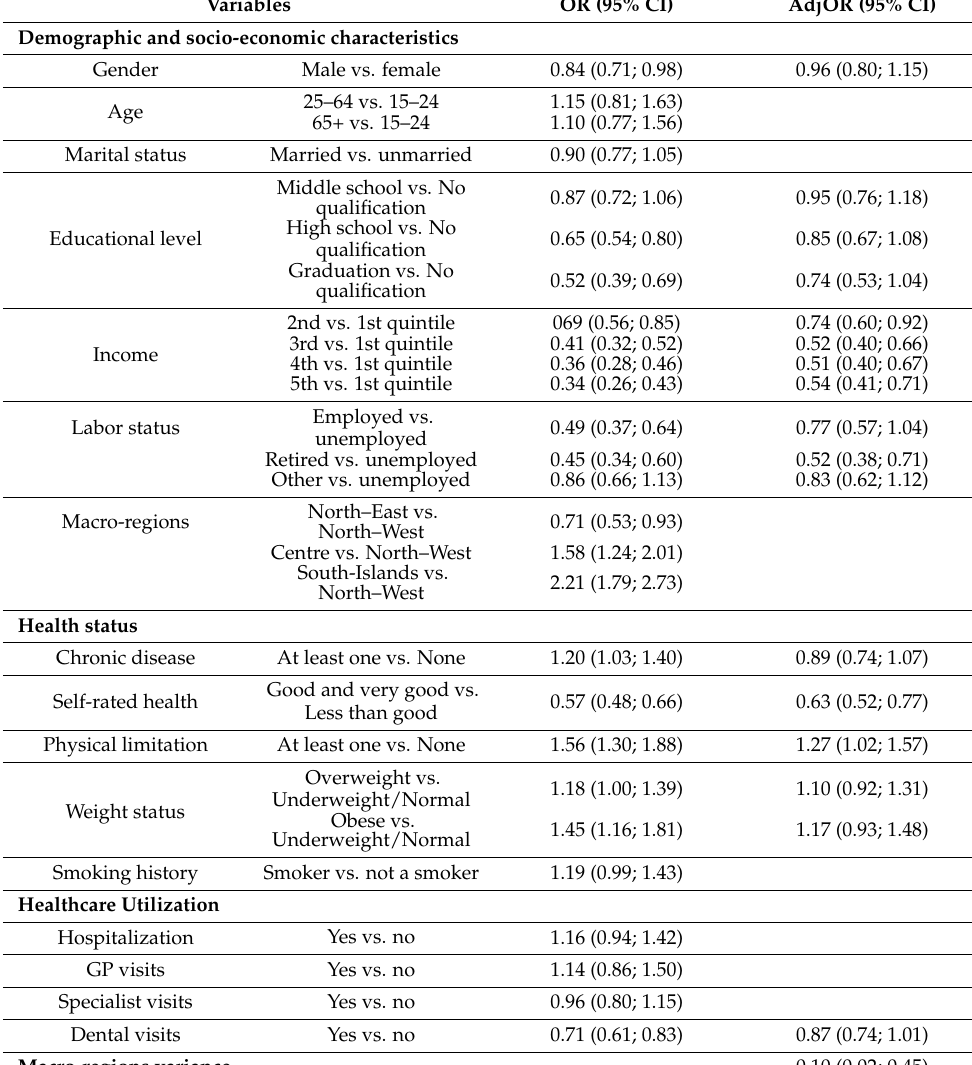
Table 5. Not purchasing drugs since they are very expensive related to socio-economic and health characteristics of respondents: Univariable and multivariable